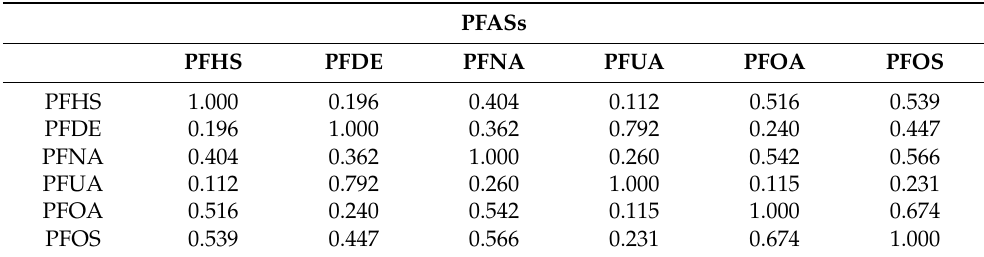
Table 4. Correlation between PFASs